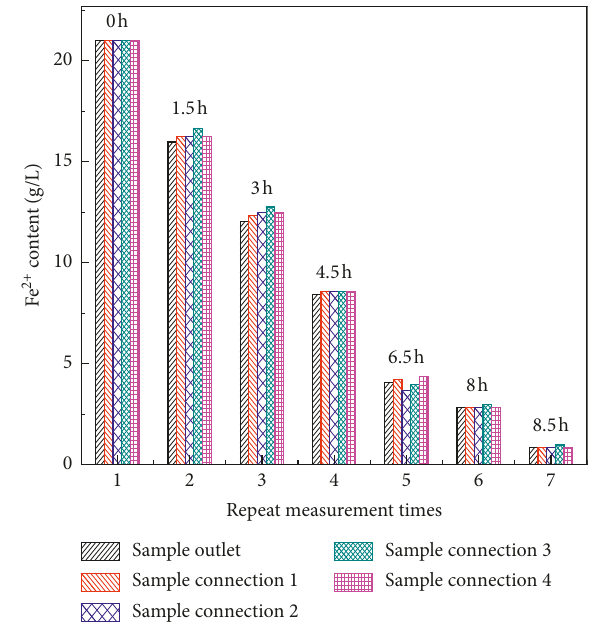
Figure 9: Fe 2+ content in various parts of the bioreactor